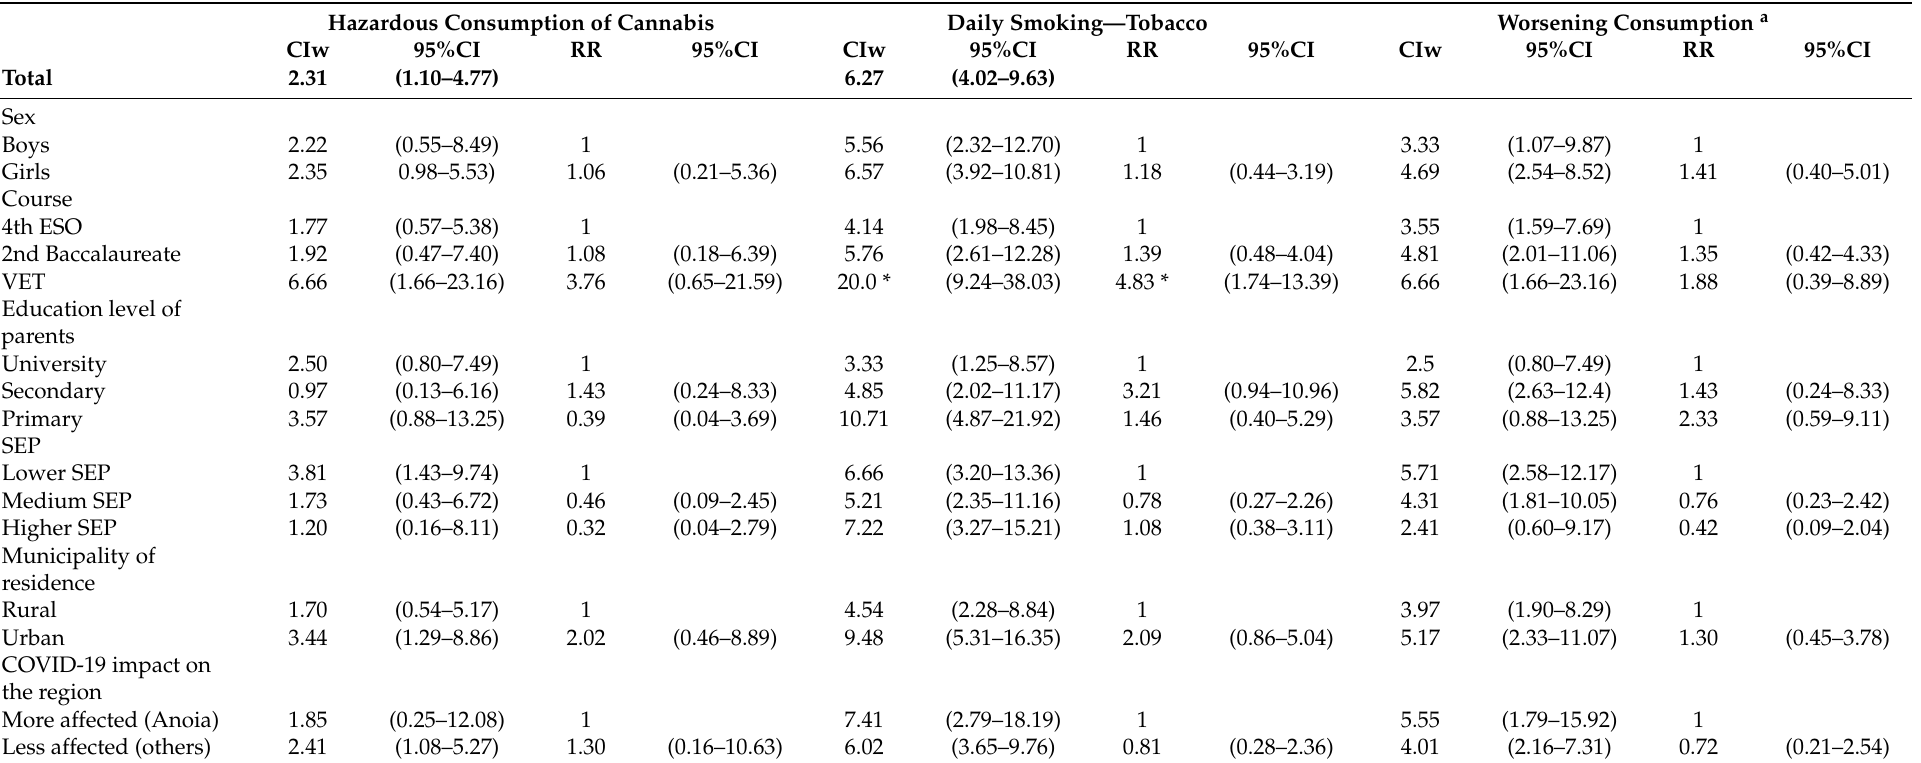
Table 5. Cumulative Incidence of worsening of hazardous consumption of cannabis, and daily smoking, between groups during confinement and their associated factors in adolescents from Central